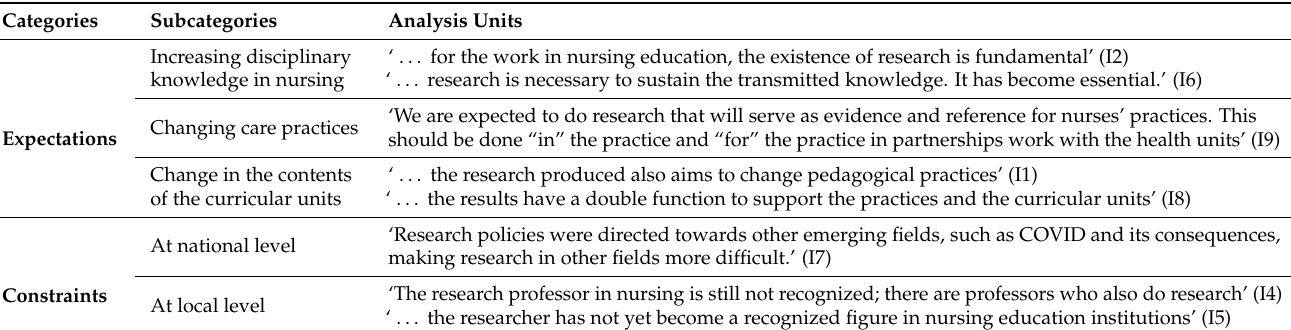
Table 1. Categories and